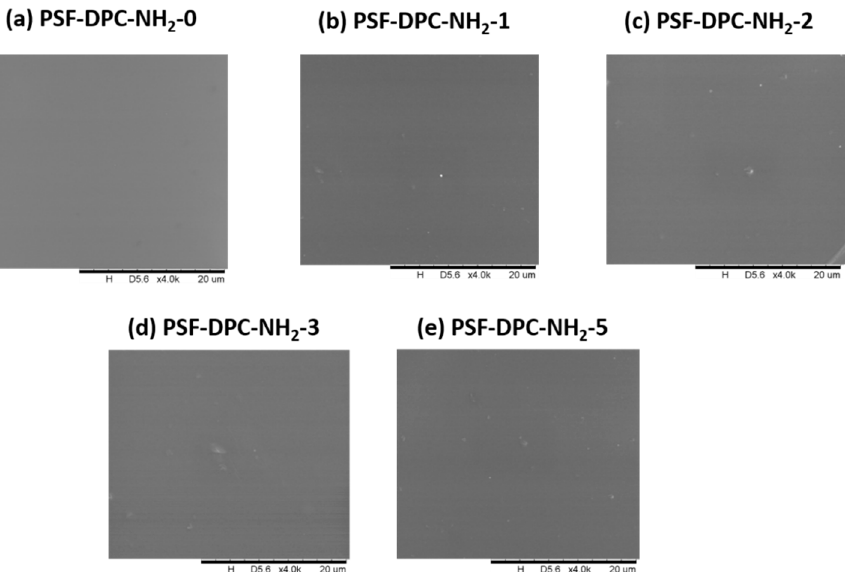
Figure 3. Surface SEM of DPC-NH 2 composite membrane for ( a ) PSF-DPC-NH 2 -0, ( b ) PSF-DPC-NH 2 - 1, ( c ) PSF-DPC-NH 2 -2, ( d ) PSF-DPC-NH 2 -3, and ( e ) PSF-DPC-NH 2 -5, for the pure PSF membrane and the CMB’s with the DPC loads of 1 wt%, 2 wt%, 3 wt%, and 5 wt%,